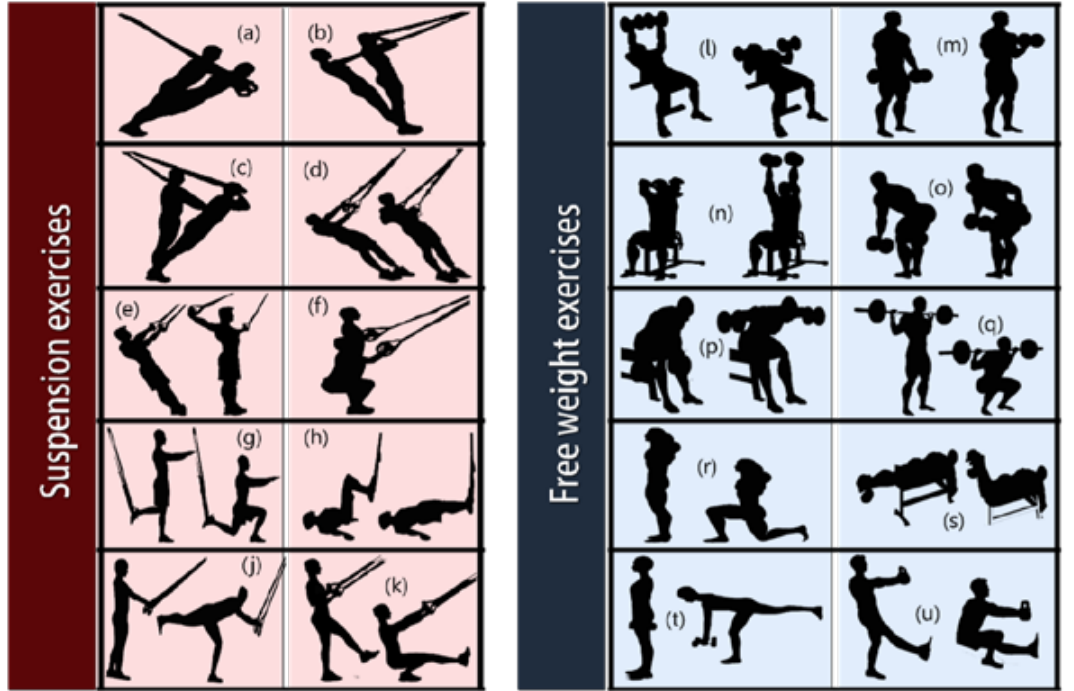
Figure 1. Exercises in different training programs (suspension training VS free weight training)